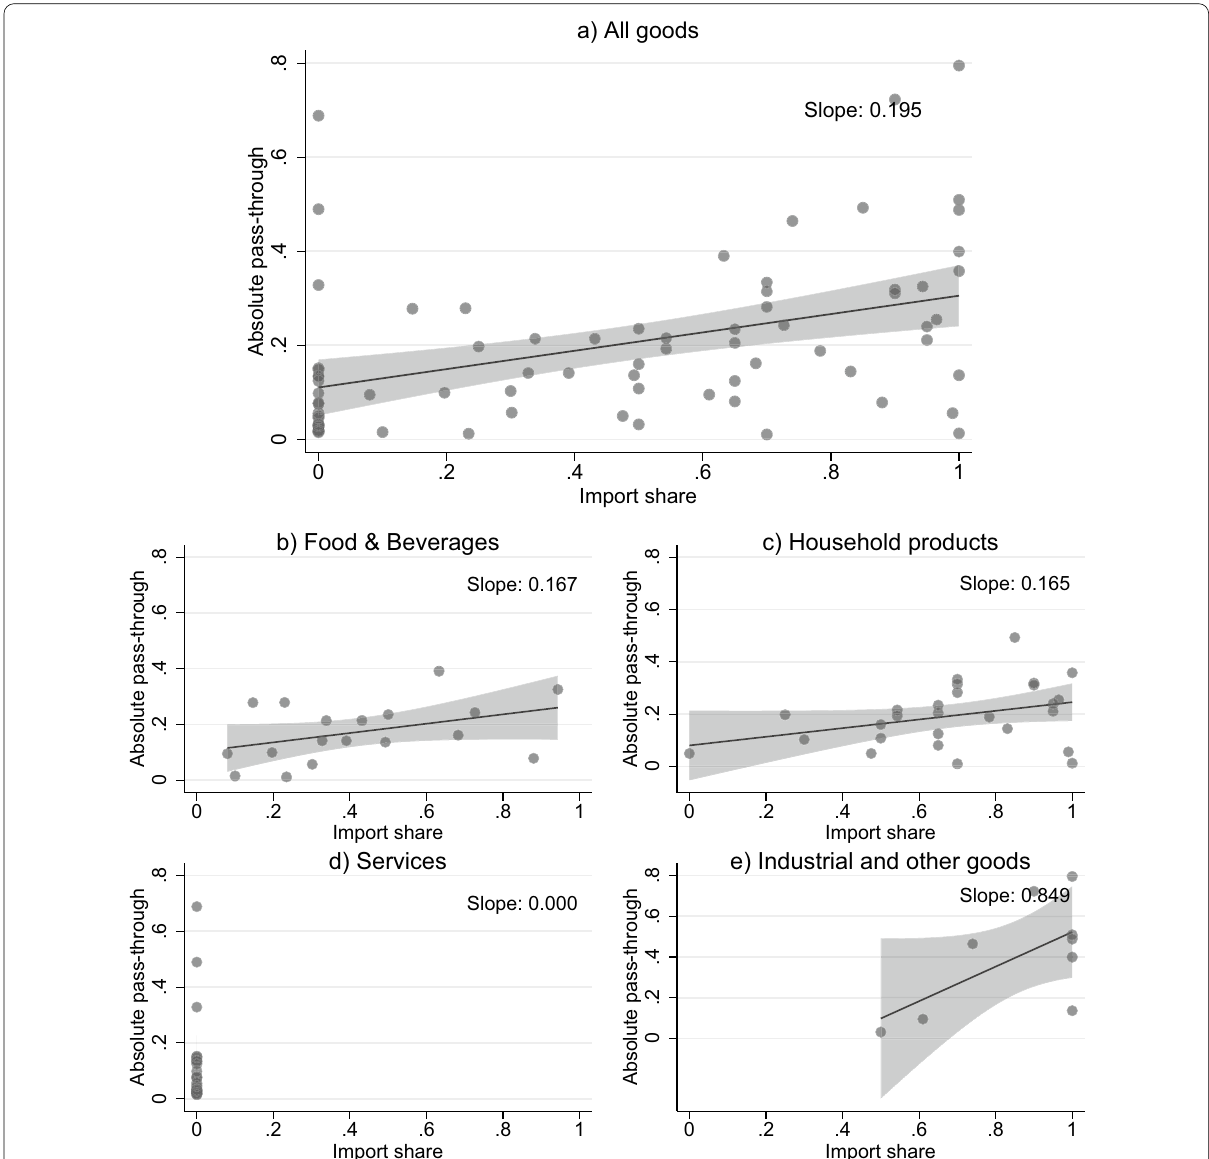
Fig. 6 Import share and pass-through across HICP categories. Notes: Linear regression of the synthetic pass-through estimates on the import share for HICP goods and services, separated by class. The slope of the regression lines are shown in the charts. Import share data is retrieved from the SFSO. Pass-through is taken in absolute value due to a few negative values. Bands show the 95% confidence interval of the